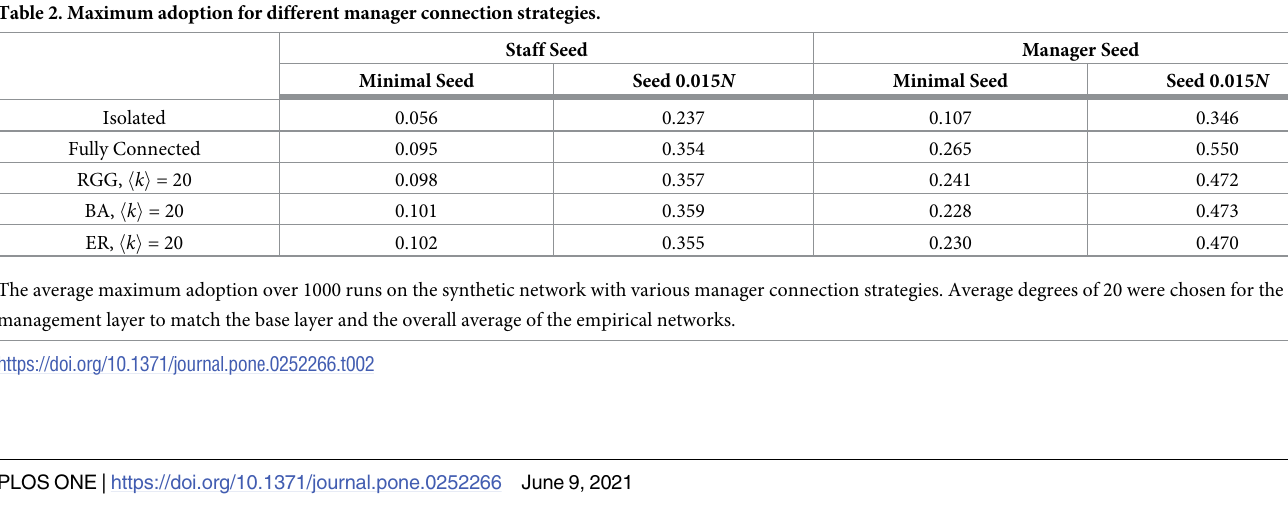
Table 2. Maximum adoption for different manager connection strategies.